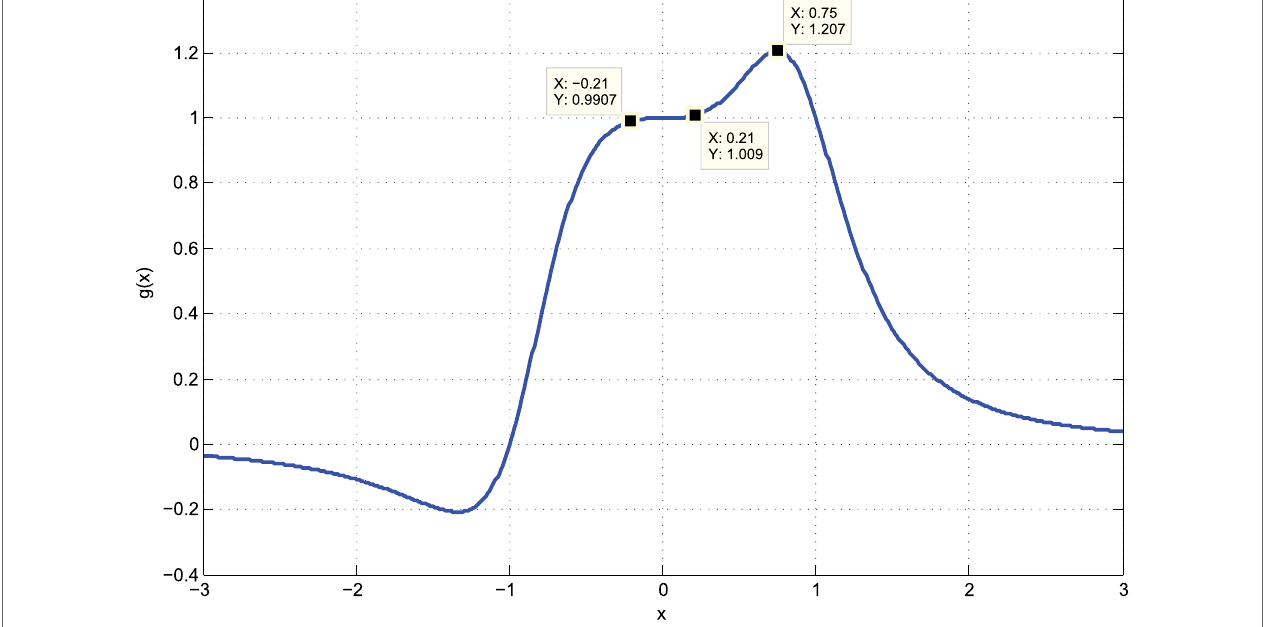
FIGURE 4 | Input-output map of the plant of example 1 .